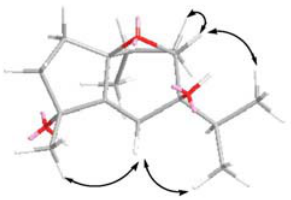
Figure 2. Selective NOESY correlations of 1 .